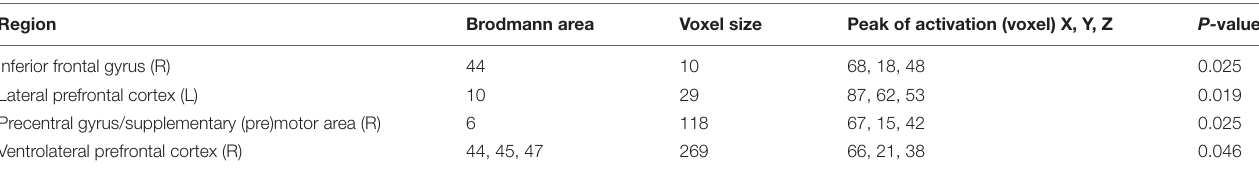
Frontiers in Behavioral Neuroscience |